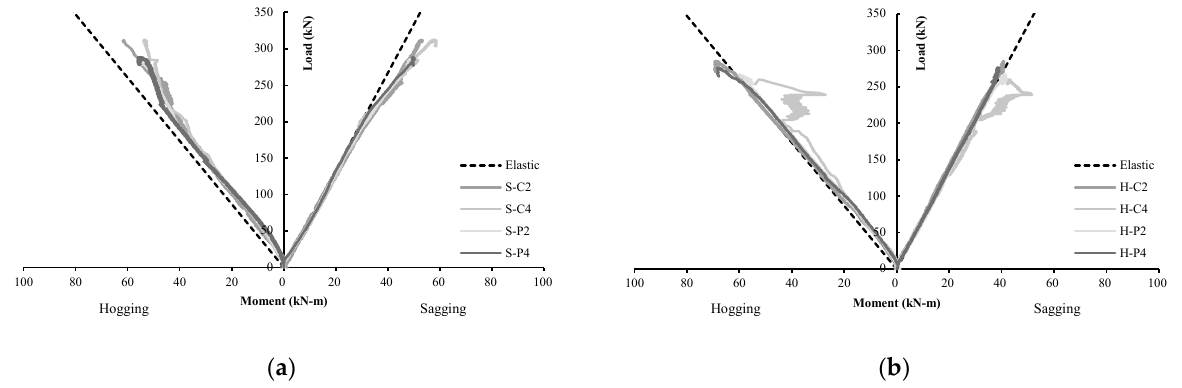
Figure 12. Experimental load–moment relationships: ( a ) Group A (sagging strengthening); ( b ) Group B (hogging strengthening). Table 4. Moment redistribution at ultimate load.